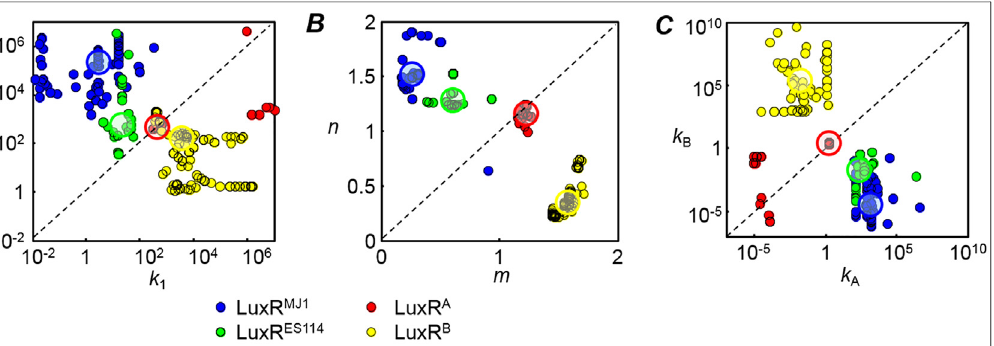
Fig 7. Correlation between interaction parameters for C8-HSL and 3OC6-HSL. Correlation between interaction parameters for C8-HSL (horizontal axes) and 3OC6-HSL (vertical axes) is shown for the four LuxR variants. All strains are Δ ainR . Each point represents parameter values obtained in one of the 150 fits performed for each LuxR. The color code (blue = LuxR MJ1 , green = LuxR ES114 , red = LuxR A , yellow = LuxR B ) indicates the LuxR variant. Panels ( A) , ( B) , and ( C ) show results for complex dissociation ( k 1 , k 2 ), Hill coefficient ( m , n ), and lux binding ( k A , k B ) respectively. The black dashed line in each panel corresponds to equality between C8-HSL and 3OC6-HSL parameters; k 1 = k 2 , m = n , or k A = k B . The larger shaded circles highlight (with the same color code) the median value obtained for each